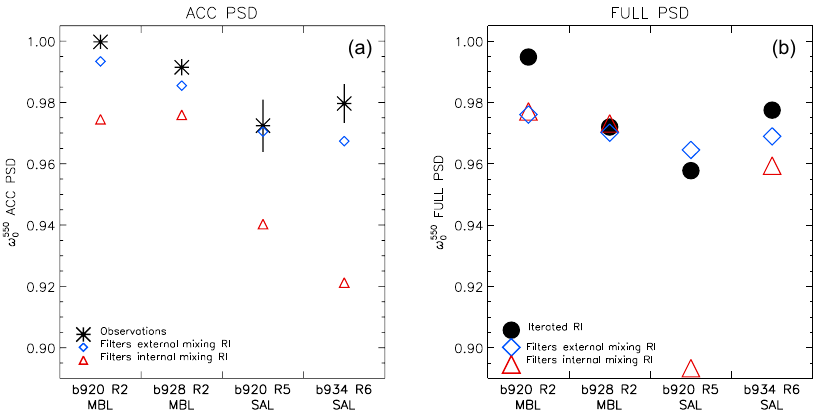
Figure 14. Comparison of SSAs calculated using different RI methods for (a) the ACC PSD and (b) the FULL PSD. Observations are only available for the accumulation mode, shown in (a) . SSA is calculated using RI derived from filter samples assuming internal and external mixing or iterated